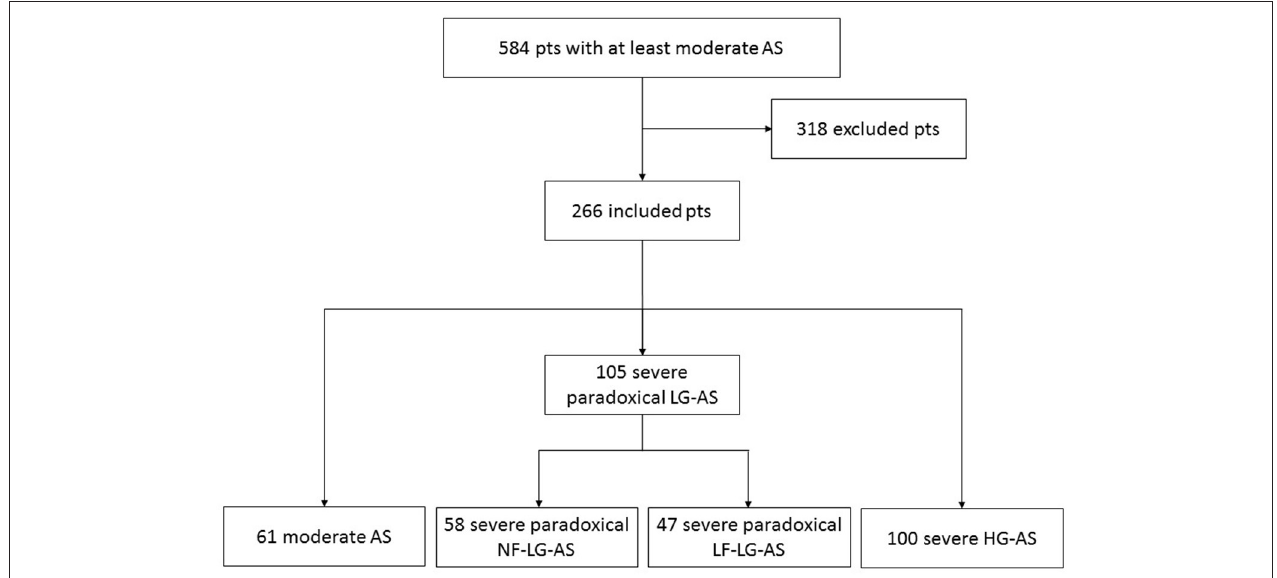
FIGURE 1 | Flow chart of the study population. Pts, patients; AS, aortic stenosis; NF, normal flow; LF, low flow; LG, low gradient; HG, high